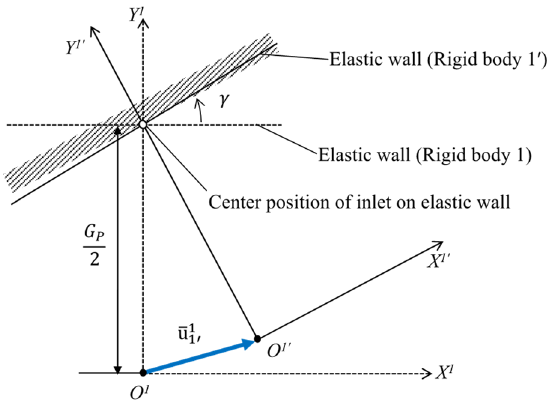
Figure 5. Outline of deformed upper inlet.